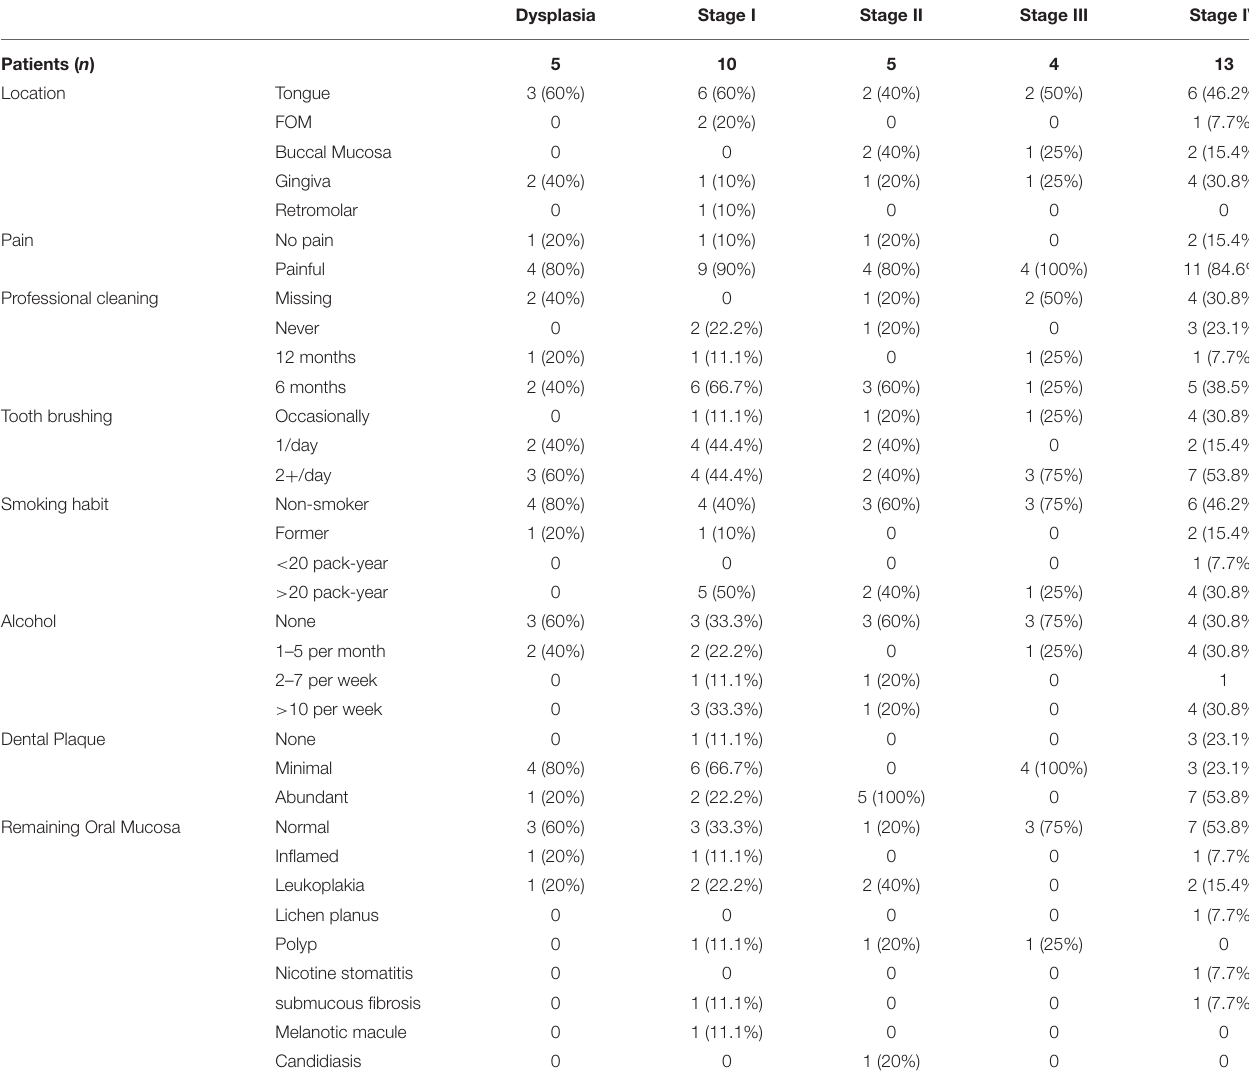
TABLE 2 | Clinical features of the